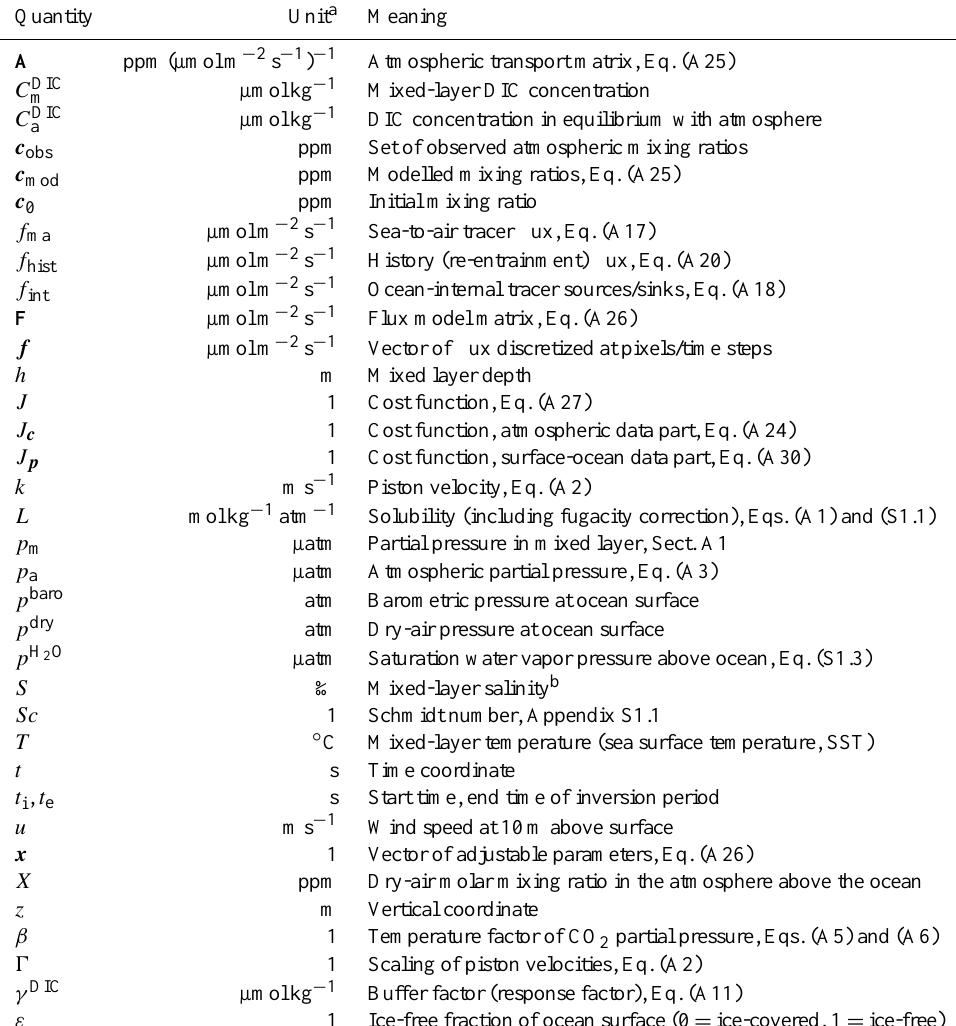
Table 2. Mathematical symbols (also see Table 3). Some quantities are indexed by species or other distinctions explained in the text.